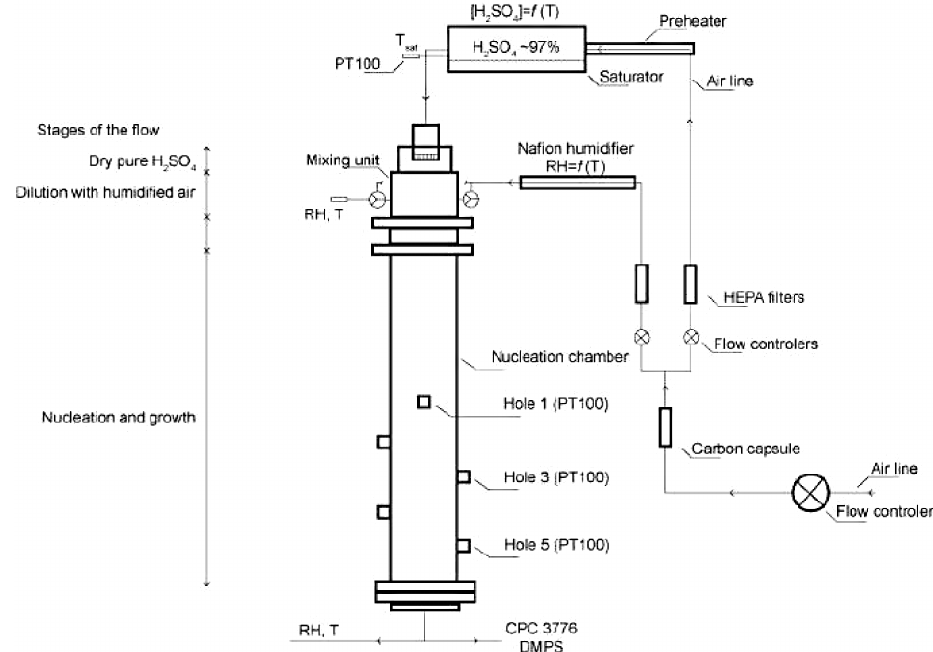
Figure 1. Schematic figure of the experimental set-up.